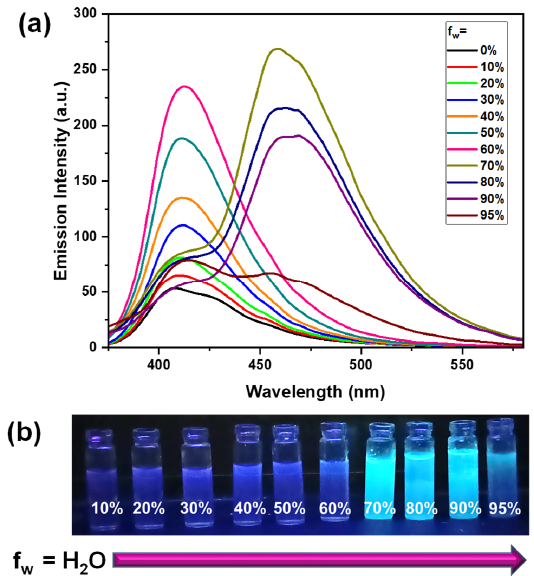
Figure 1 . ( a ) Emission spectra of L1 (c, 50 μM, λ ex = 350 nm) in a MeOH - H 2 O mixture with water Figure 1. ( a ) Emission spectra of L1 (c, 50 µ M, λ ex = 350 nm) in a MeOH-H 2 O mixture with water fraction increasing from 0‒95%; ( b ) optical images of vials containing L1 in MeOH with water frac- fraction increasing from 0–95%; ( b ) optical images of vials containing L1 in MeOH with water fraction tion increasing from 10–95% under the UV illumination. increasing from 10–95% under the UV